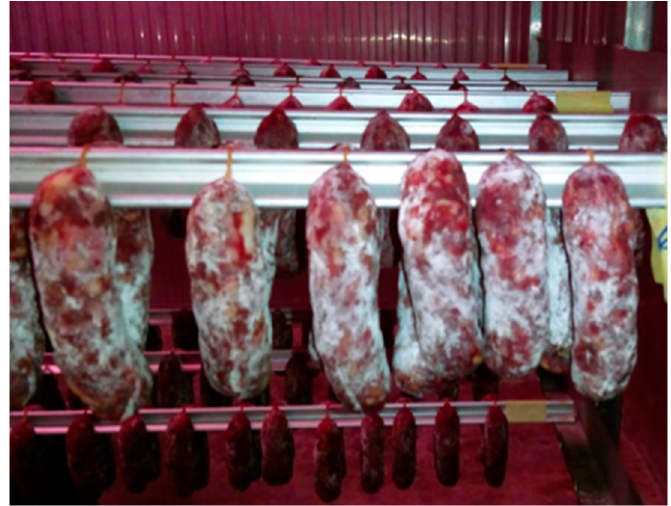
Figure A1. Salami in the last seasoning period.